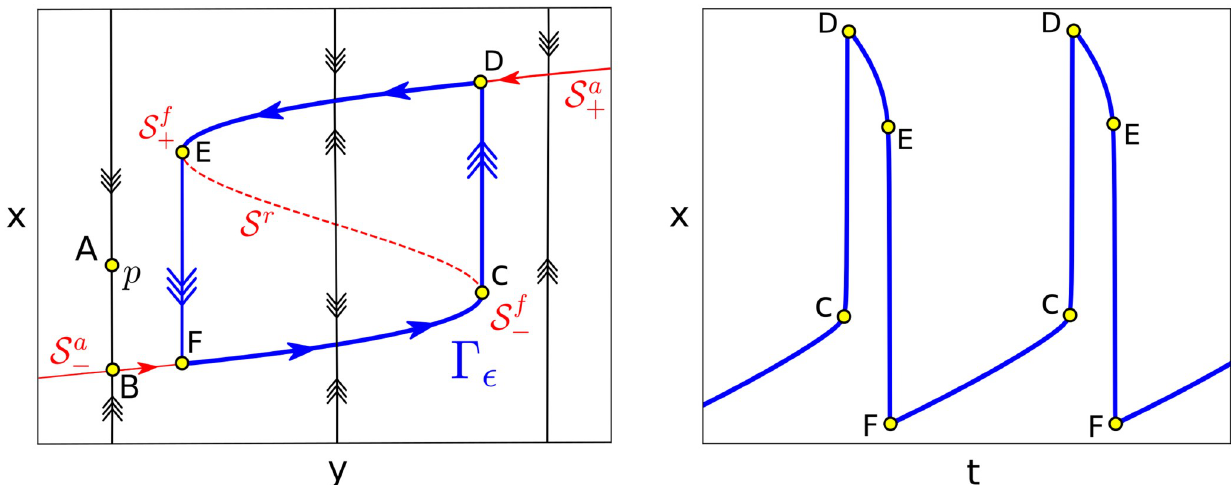
Fig 1. Phase space for relaxation oscillators. The slow manifold, S , is a S-shaped curve having two stable branches S a (solid red line) and one repelling S r � (dashed red line) (see Eq (4)). Stable and unstable branches of S are separated by the fold points S f . A given point, p , (see A) will quickly converge to the � (see B). Then, it evolves along S a following (6) until reaching the fold point S f (see C) where it traverses fast to attracting branch of the slow manifold S a (cid:0) (cid:0) (cid:0) the other branch S a (see D). Then, following again the slow dynamics, the trajectory approaches S f (see E) where it goes back to S a (see F). Therefore, the þ þ (cid:0) system (1) in the singular limit ( � ! 0) admits a singular periodic orbit Γ � (in blue) generating relaxation